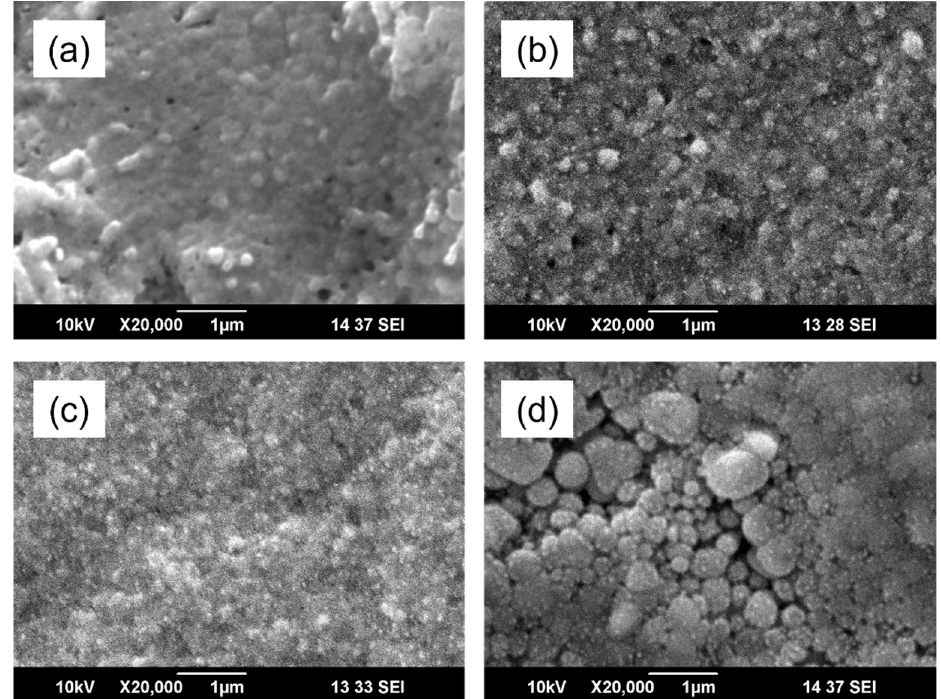
Figure 5. SEM images of ( a ) FA 0.8 Cs 0.2 PbI 2.85 Br 0.15 , ( b ) FA 0.8 Cs 0.2 PbI 2.5 Br 0.5 , ( c ) FA 0.8 Cs 0.2 PbI 2.3 Br 0.7 , and ( d ) FA 0.8 Cs 0.2 PbI 2 Br 1 films deposited on FTO-coated glass substrates. The FA 0.8 Cs 0.2 PbI 2.85 Br 0.15 sample shows smaller grains than the wide bandgap